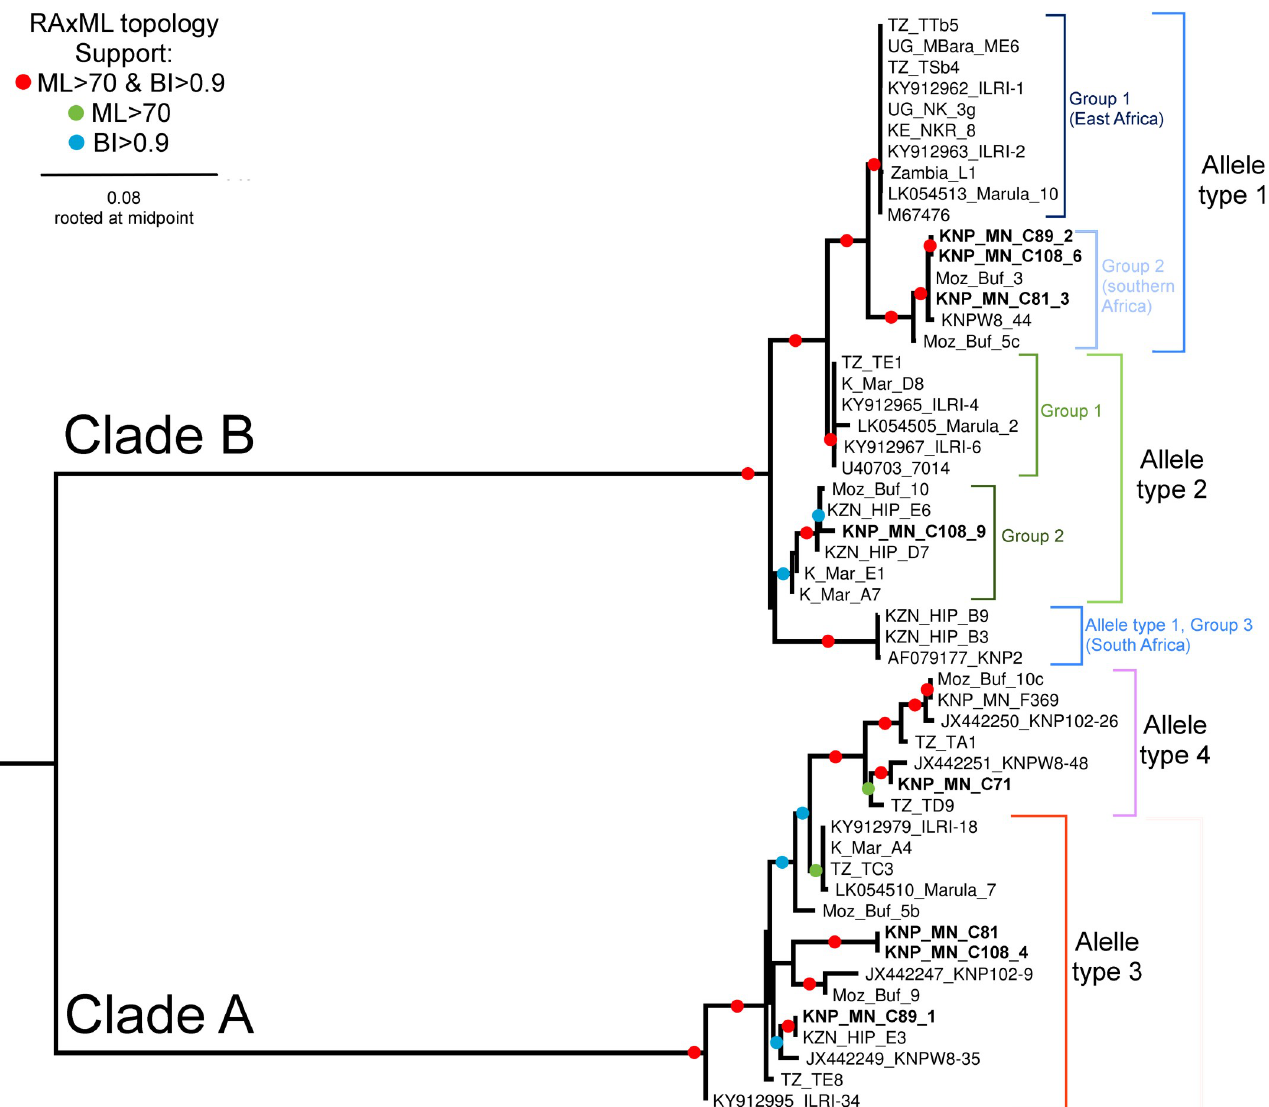
Fig 2. Topology recovered from maximum likelihood analysis in RAxML using GTR+I+G model of evolution. Support indicated on branches are bootstrap support from RAxML with autoMRE function invoked followed by posterior probabilities calculated from saved trees using Bayesian inference. Tree rooted at midpoint. Allele types are based on previous description [22, 27]. Sequences from parasites from clinical cases of Corridor disease are bolded. Detail on all the sequences is provided in S6 Table. https://doi.org/10.1371/journal.pone.0231434.g002 (Fig 2). Clade B comprised of p67 sequences representing allele types 1 and 2 obtained from cattle- and buffalo-derived T . parva parasites (Fig 2). Among the allele type 1 sequences, there was a clear isolation pattern between T . parva parasites from East Africa (group 1) and south- ern Africa (group 2) (Fig 2). Allele type 1 group 1 comprised of sequences from cattle-derived T . parva parasites exclusively from East Africa, as well as sequences from buffalo-derived T . parva parasites from cattle (KY912962) and buffalo (KY912963) from Kenya. Allele type 1 group 2 comprised of sequences from the buffalo-derived T . parva parasites exclusively from cattle from South Africa, and buffalo from Kruger National Park in South Africa and Marro- meu National Reserve in Mozambique. Interestingly, from the network, allele type 1 group 1